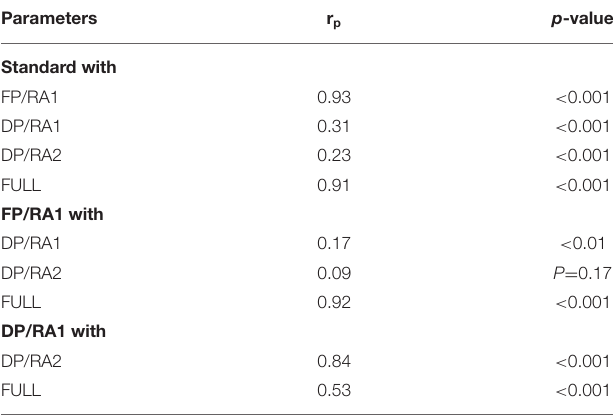
TABLE 5 | Correlation analysis between parameters of the surface